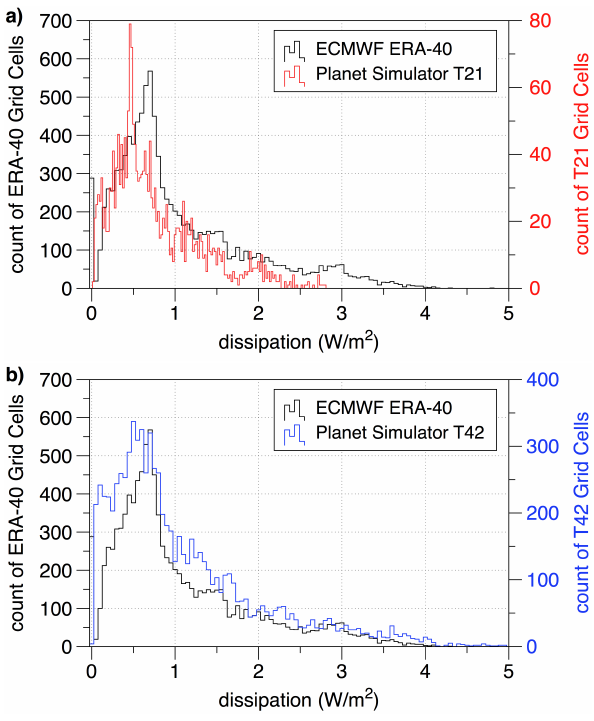
Fig. 4. Global mean dissipation values for (a) ERA-40 and a T21 10-vertical layer simulation and (b) ERA-40 and T42 10-vertical layer simulation.